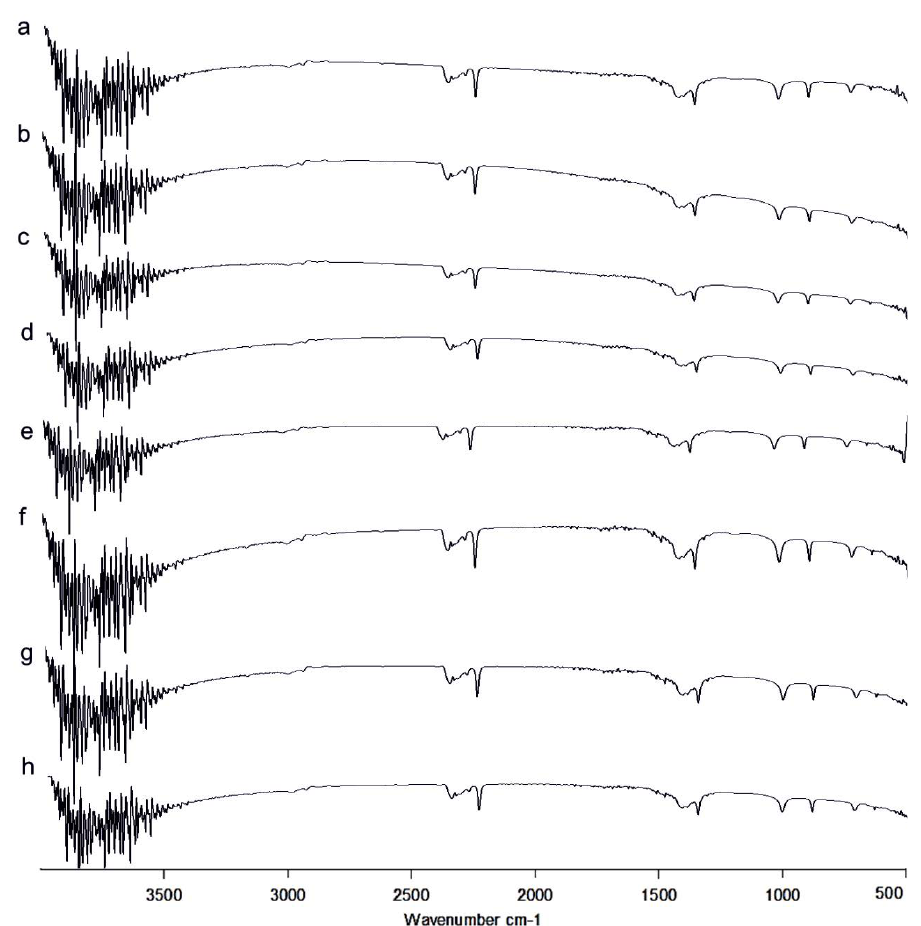
Fig. 4. FT-IR of Acyl Homoserine